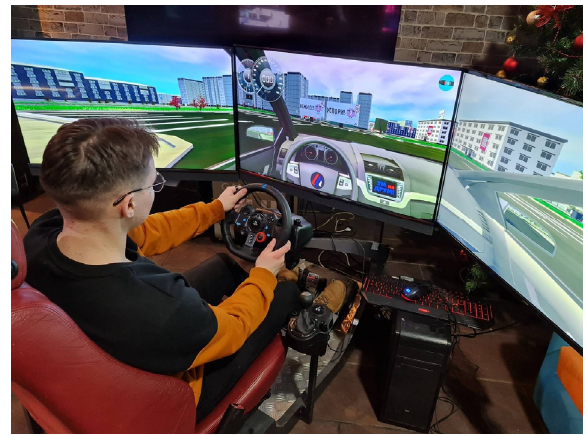
Figure 1. Driving simulator—billboard.